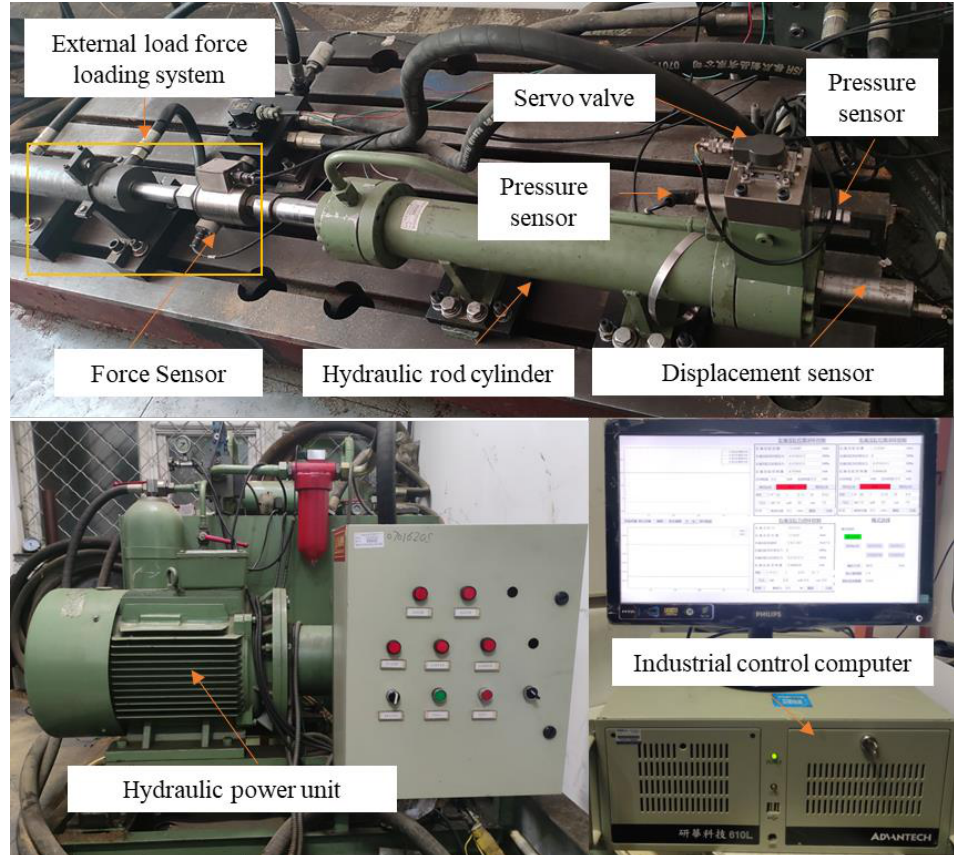
Figure 3. The platform of the hydraulic servo system.